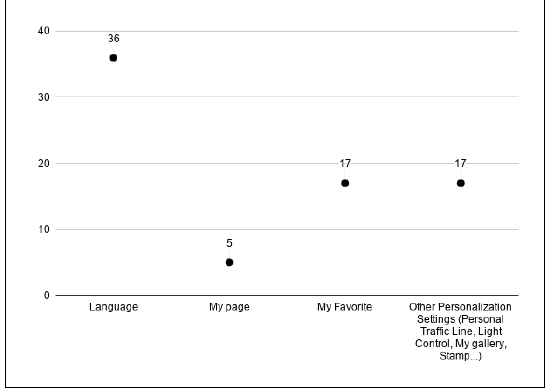
Figure 3. Customisable profile that shows participatory access in 36 museums of